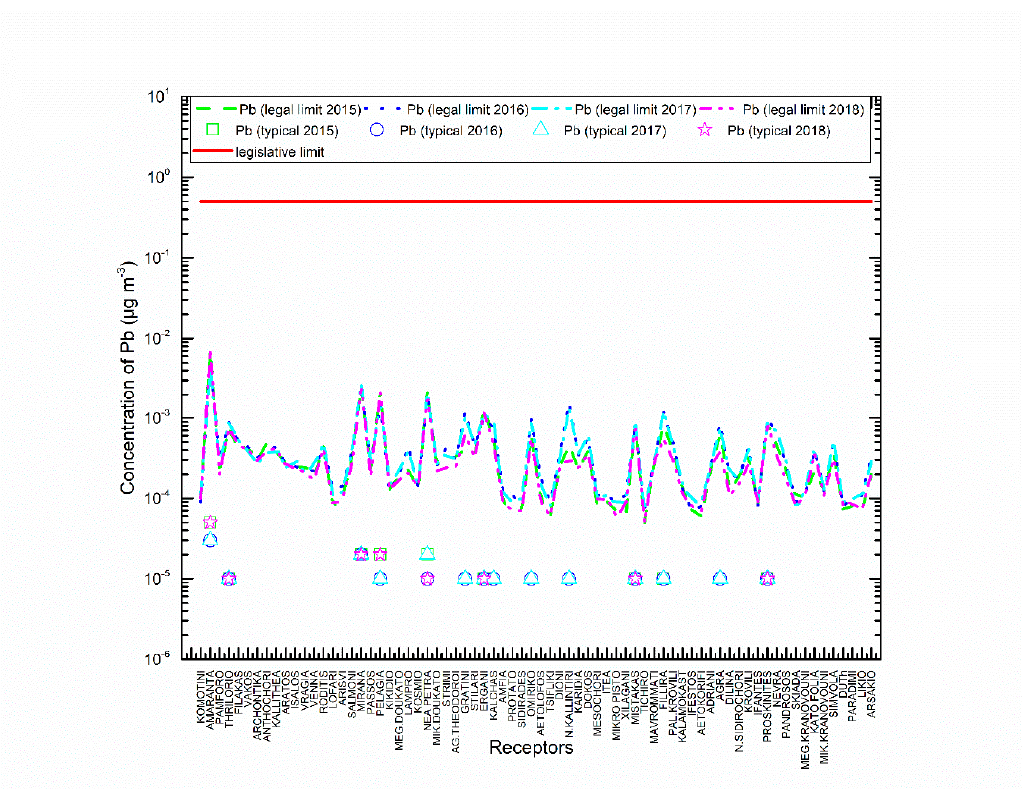
Figure 4. Annual average concentration of Pb ( µ g m − 3 ) for 72 receptors compared to the annual legislation limit of 0.5 µ g m − 3 .